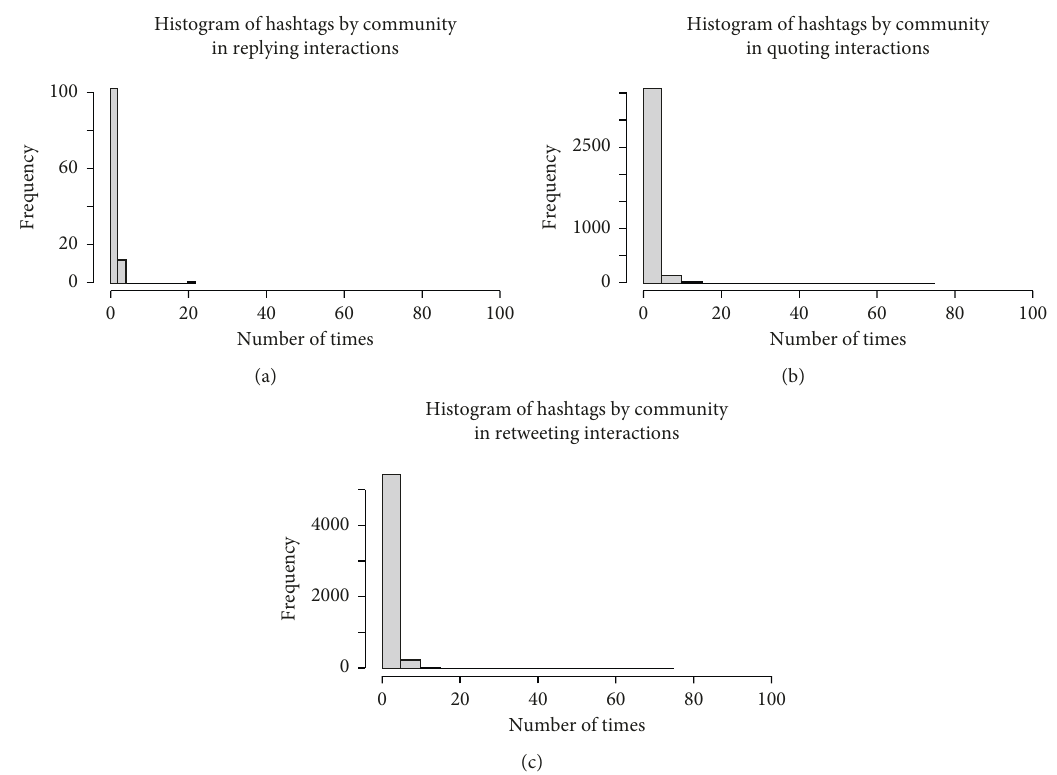
Figure 8: For replying (a), retweeting (b), and quoting (c) interactions, histograms of hashtags by community.